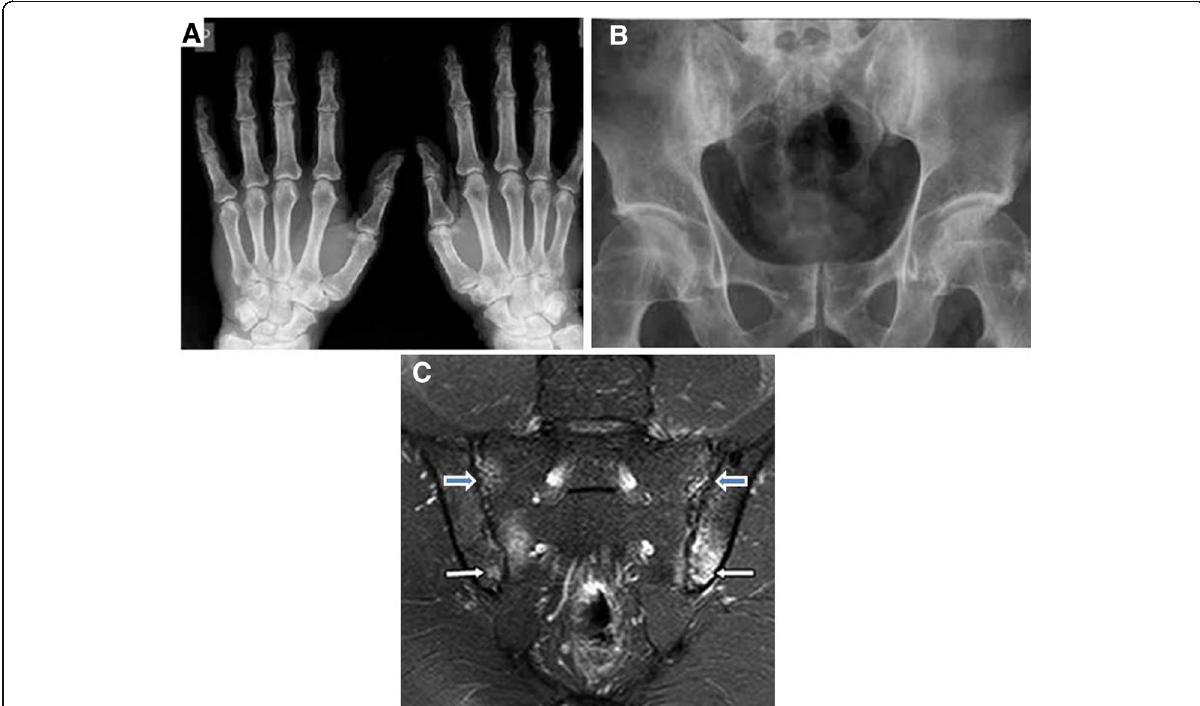
Fig. 4 Female patient 37 years with spondyloarthritis. a X-ray both hand AP view showed erosion of the DIP joints with periarticular osteopenia. b X-ray sacroiliac joint showed bilateral sacroiliitis ( b ). T2WI of both sacroiliac joints showed bone marrow edema (thick arrow), more in right sacroiliac joint, with right posterior subchondral erosion (small